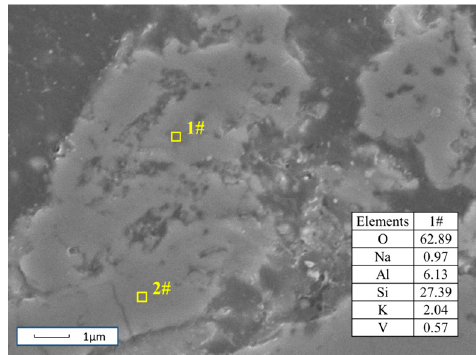
Figure 6. The SEM pattern of Na 2 SO 4 -Na 2 CO 3 composite salt leaching residue. 1#—melt, and 2— quartz.